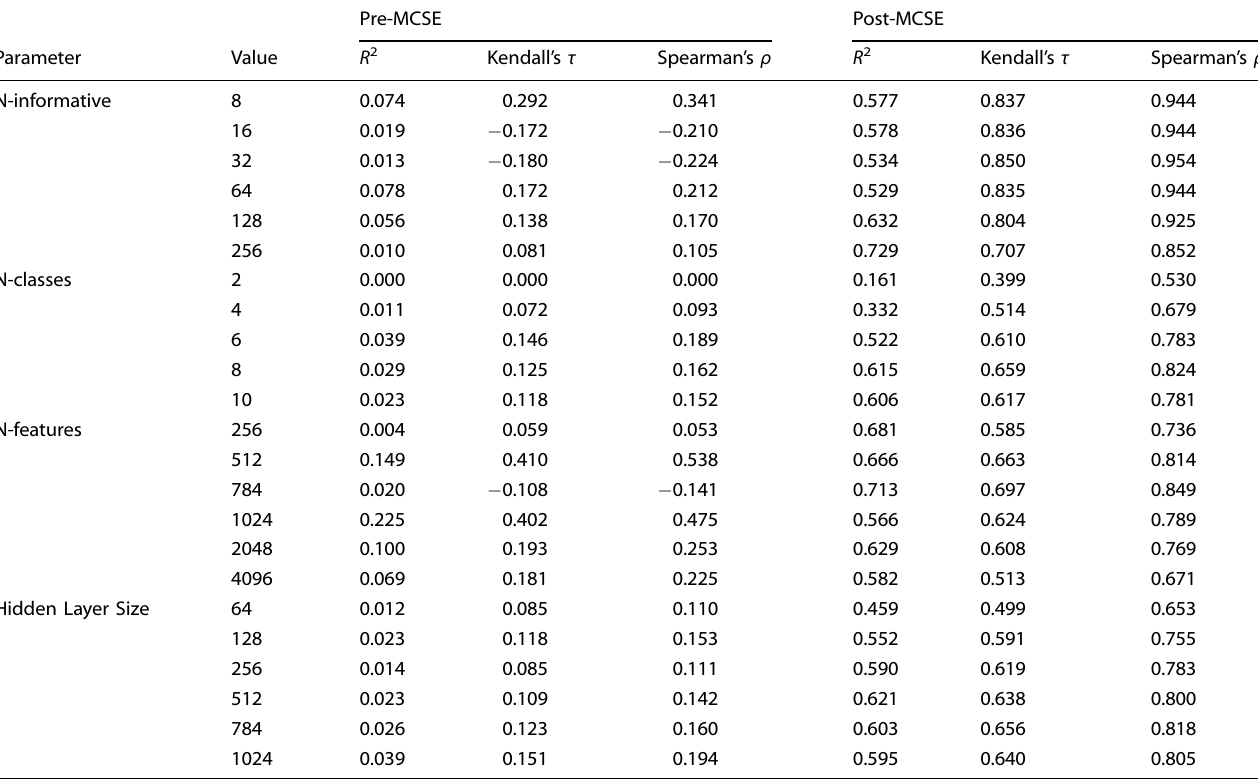
Table 2. Correlation between test area-under-the-curve and sample size above and below auto-encoder loss in fl ection points for with varying dataset characteristics and neural network